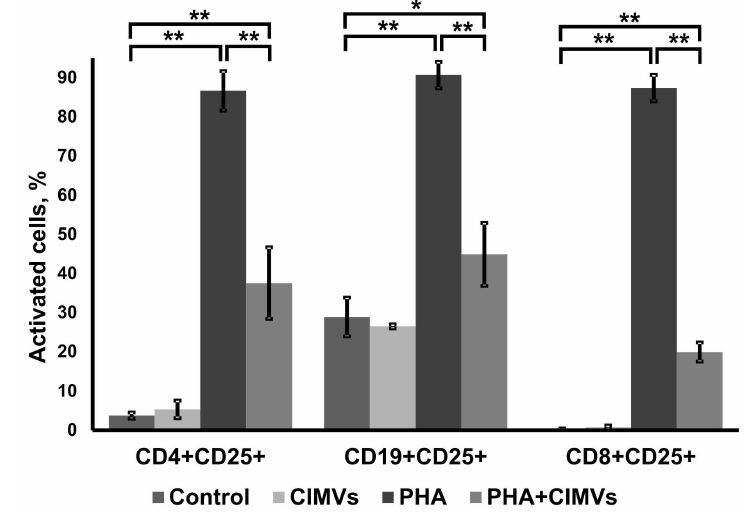
Figure 6. E ff ect of CIMVs-MSCs on lymphocyte activation. Lymphocytes were incubated with CIMVs-MSCs for 24 h followed by PHA activation (10 µ g / mL). PBMCs were incubated with anti-CD4, anti-CD19, anti-CD8, and anti-CD25 monoclonal antibodies three days after PHA activation. The percent of activated cells was determined as CD25 + cells using flow cytometer BD FACS Aria III (BD Bioscience, USA). Experiments were repeated three times. The data represent mean ± SD. (*) Level of significance p < 0.05; (**) level of significance p <